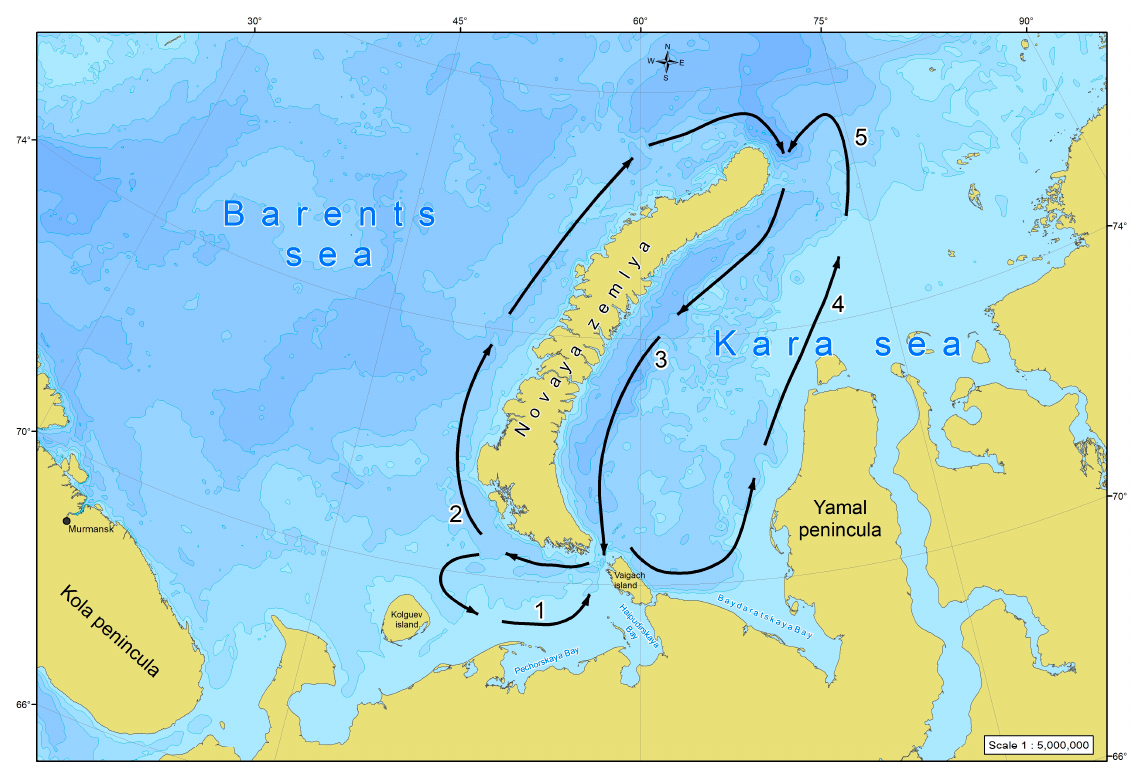
Figure 12. A schematic presentation of the major components of the water circulation in the south- eastern Barents Sea and the south-western Kara Sea: (1) Kanin, White Sea, Kolguev-Pechora, and Pechora currents; (2) Litke Current; (3) East Novaya Zemlya Current; (4) Yamal Current; (5) Ob-Yamal Current (given by: [14]).